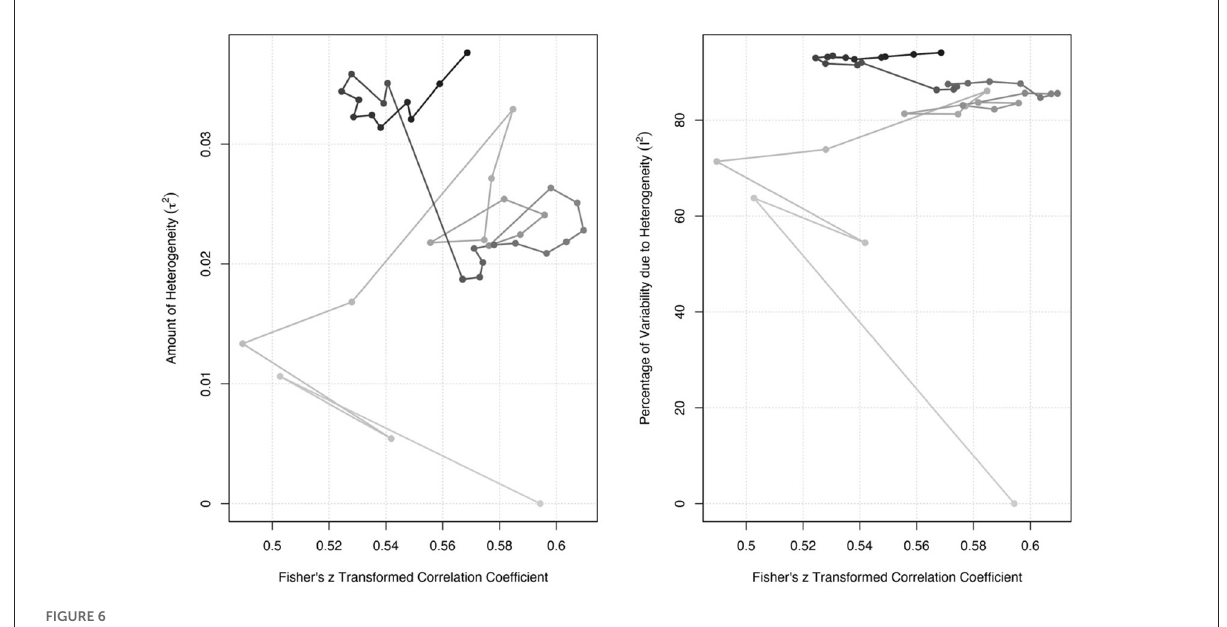
FIGURE6 The plot of cumulative results by years.